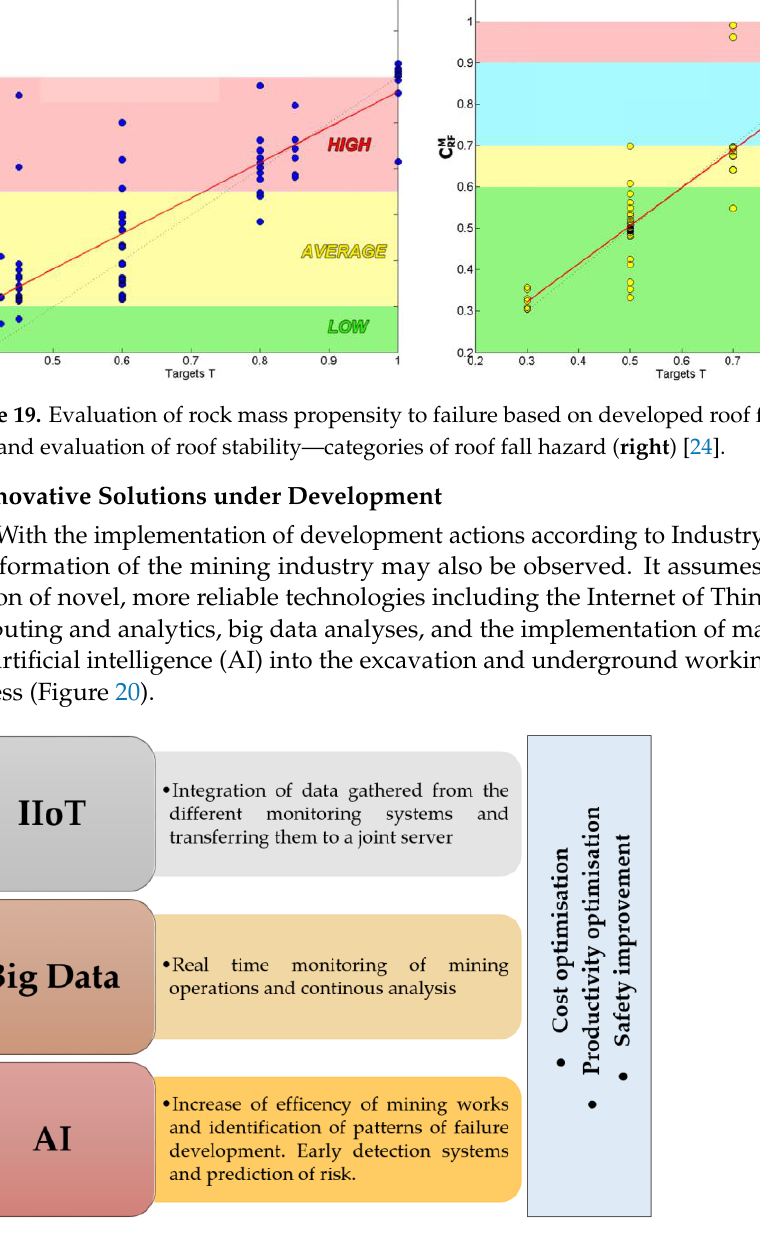
Figure 20. Key directions of mining digitalization according to Industry 4.0.